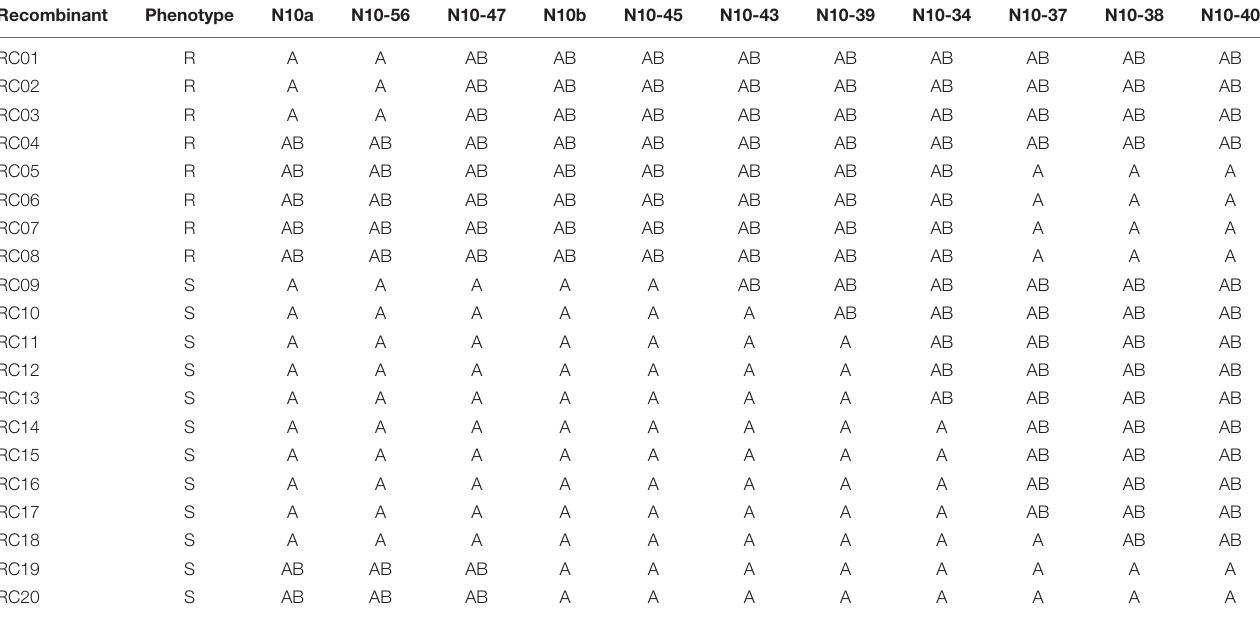
TABLE 3 | Phenotypesand genotypes of 20 recombinants in the BC 3 population of Brassica napus* .